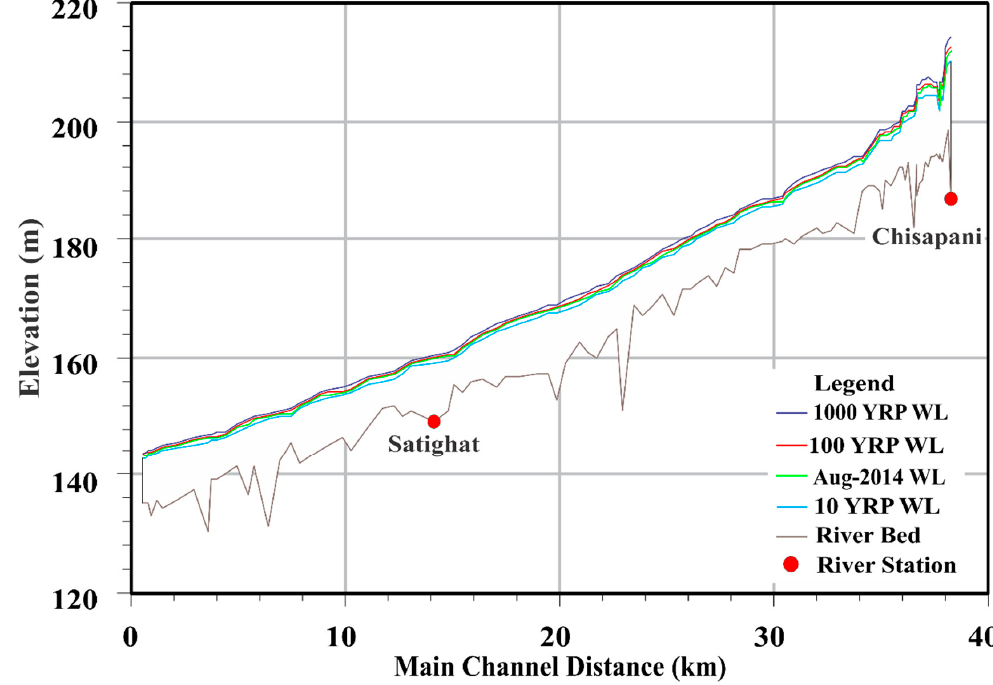
Figure 8. Water surface profile of different YRP floods in the river segment from Chisapani to the Nepal–India border. The Chisapani gauge and Satighat observation station were used for model performance evaluation.